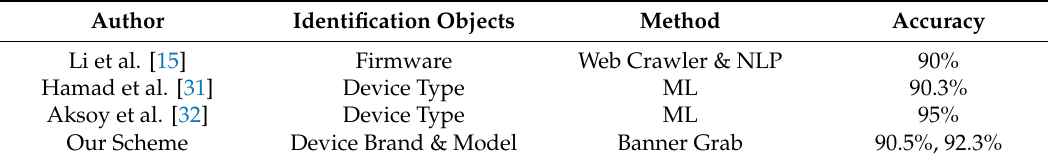
Table 4. Comparison of identification accuracy with